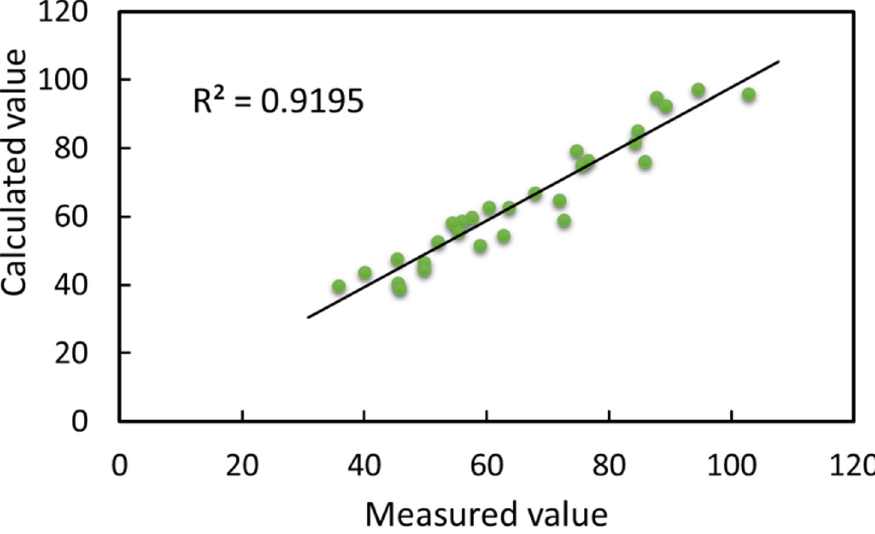
Figure 24. Linear relationship between calculated and measured values of leafstalk angle.